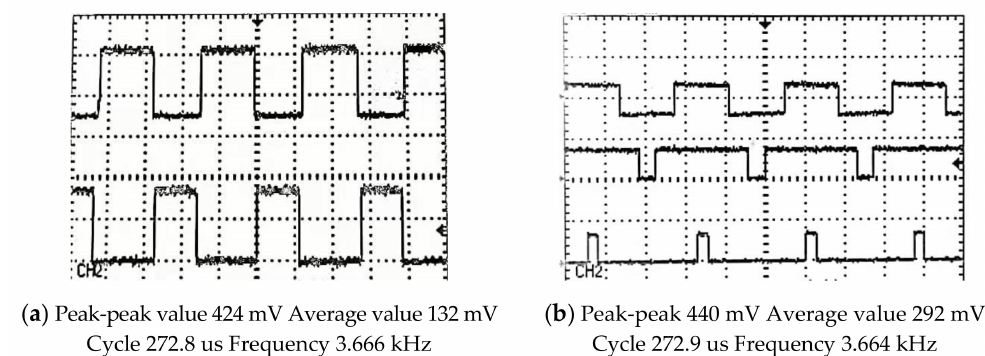
Figure 8. Observation of the PWM output waveform with an oscilloscope. ( a ) PWM waveform output on the pins of the DSP chip; ( b ) in different duty